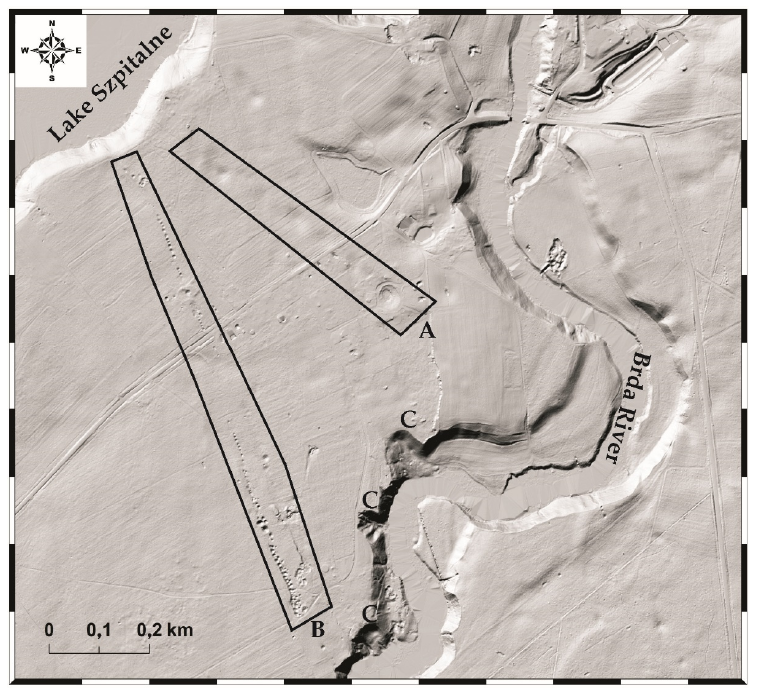
Figure 4. Detailed location of areas transformed by underground lignite mining. ( A )—subsidence landforms after the Buko mine, ( B )—subsidence landforms after the Olga mine, ( C )— subsidence recesses . Source: